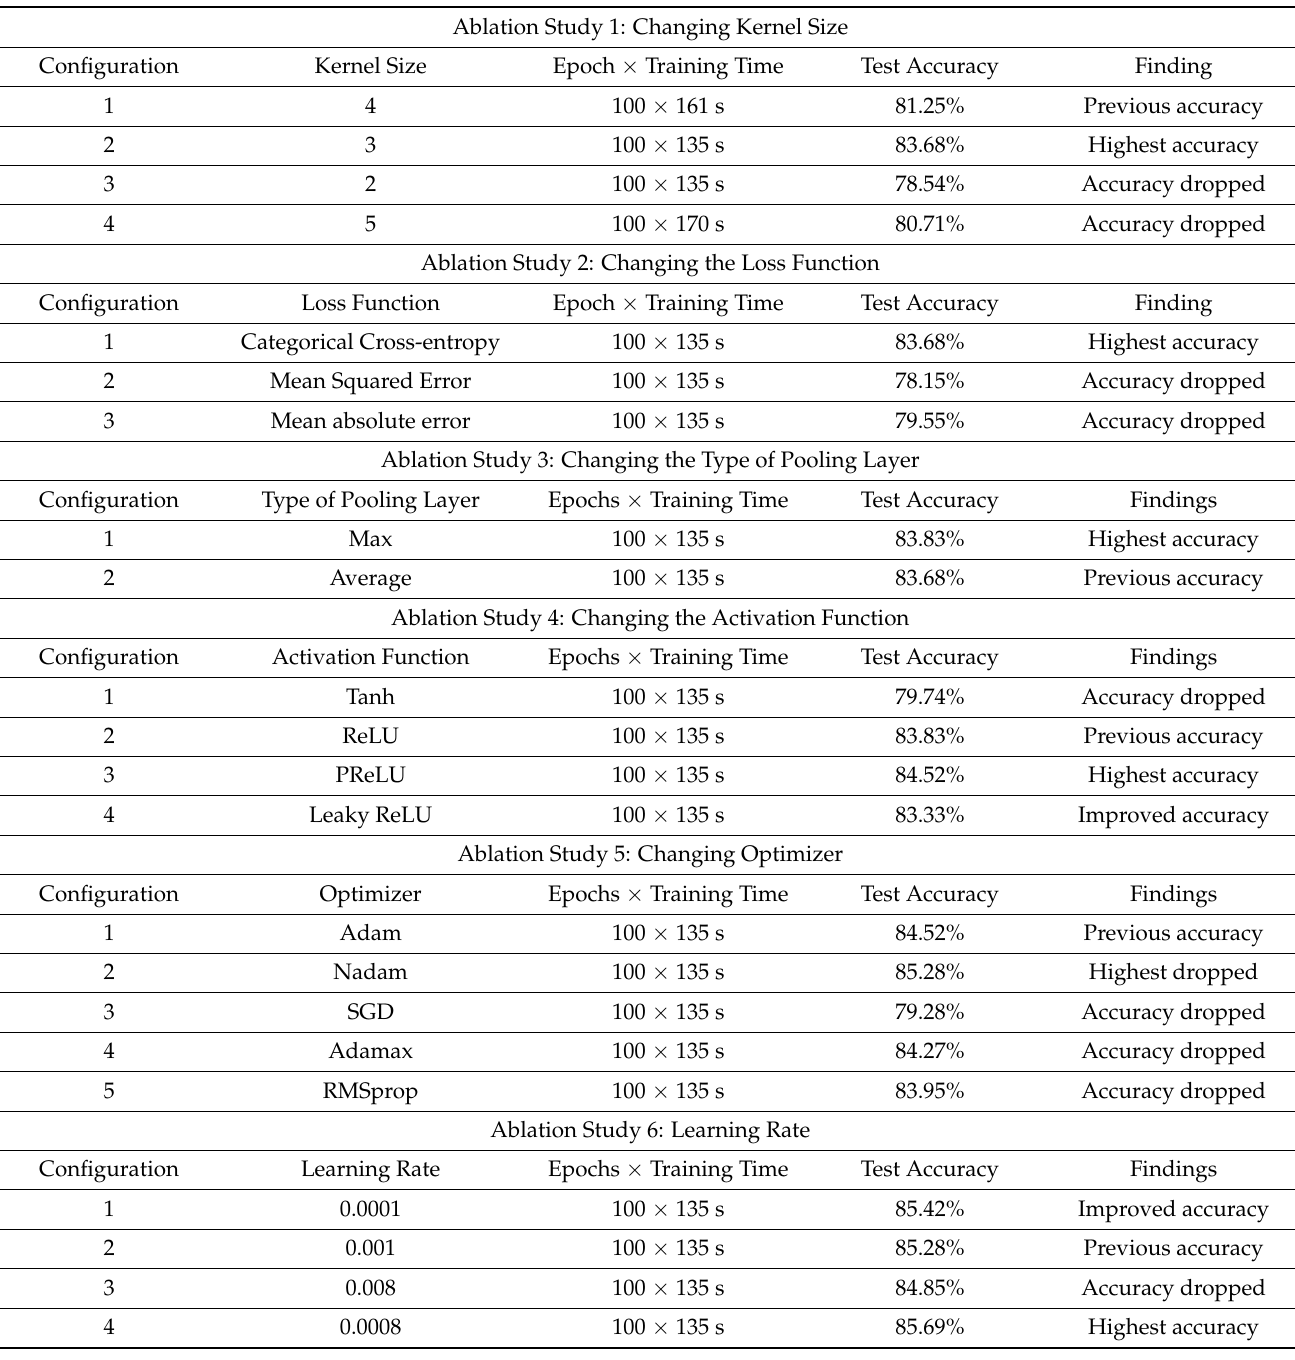
Table 2. Result of ablation